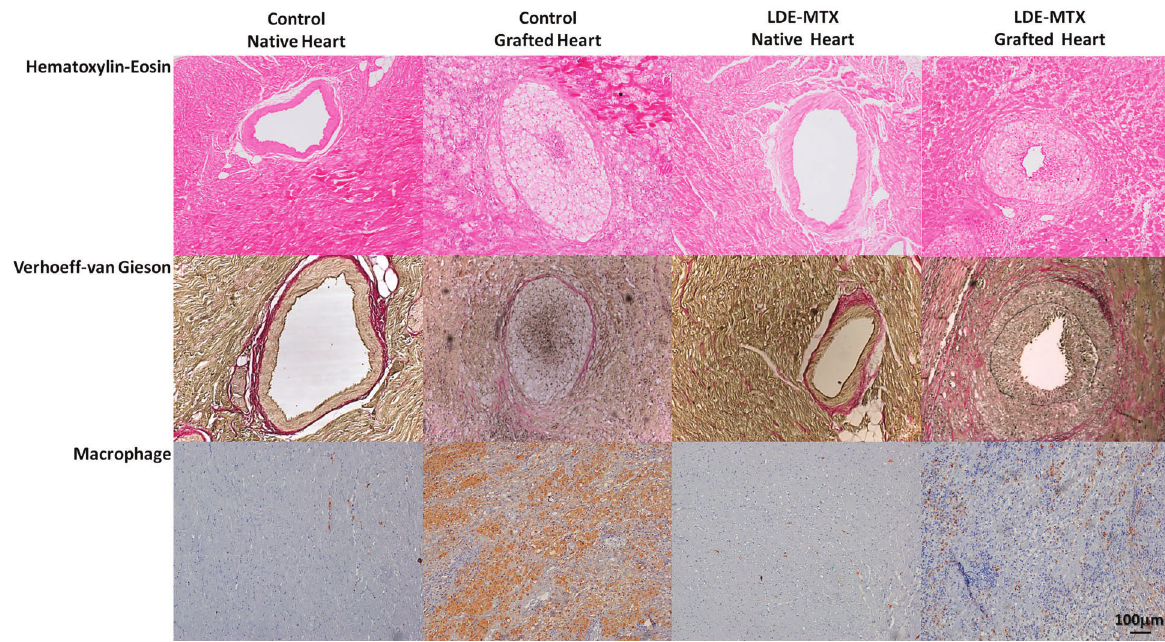
Figure 1. Native and grafted hearts of control rabbits, and native and grafted hearts of lipid nanoemulsion-methotrexate (LDE-MTX) treated rabbits stained with hematoxylin-eosin, Verhoeff-van Gieson and immunostaining for macrophages. Magni fi cation 100 (cid:3) .